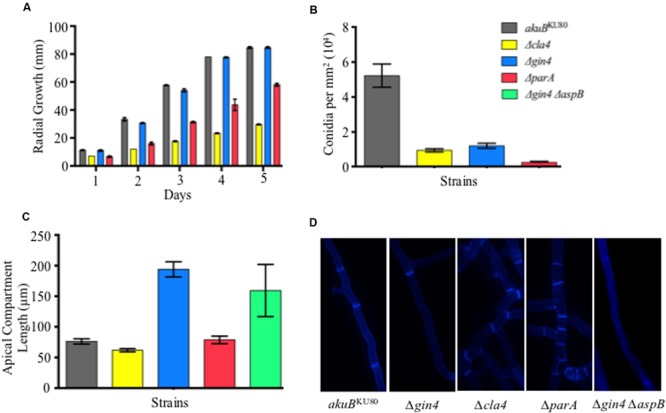
Septin regulators are required for hyphal extension, conidiation, and proper septation. (A) Deletion of parA and cla4 results in a 1.5- and 2.9-fold reduction in radial growth, respectively (p < 0.001). Conidia (104) from each septin deletion strain and wild-type strain were inoculated on glucose minimum media (GMM) and incubated for 5 days at 37°C. (B) Deletion of gin4, cla4, or parA genes resulted in a 4.4-, 5.6-, and 20.7-fold reduction in conidia production, respectively (p < 0.001). Conidia were harvested after 5 days of growth using 10 ml of 0.05% Tween-80 and the conidial count was normalized by fungal colony area. (C) Deletion of gin4 results in an increase in length of the apical compartments (p < 0.001). Apical compartments were measured following aniline blue staining by fluorescent microscopy after 20 h of incubation at 37°C. (D) Aniline blue staining revealed that strains lacking Cla4 or ParA are hyperseptated in basal compartments, while the strain lacking Gin4 contained a larger basal compartment compared to the wild-type strain. Error bars represent standard error of the mean.